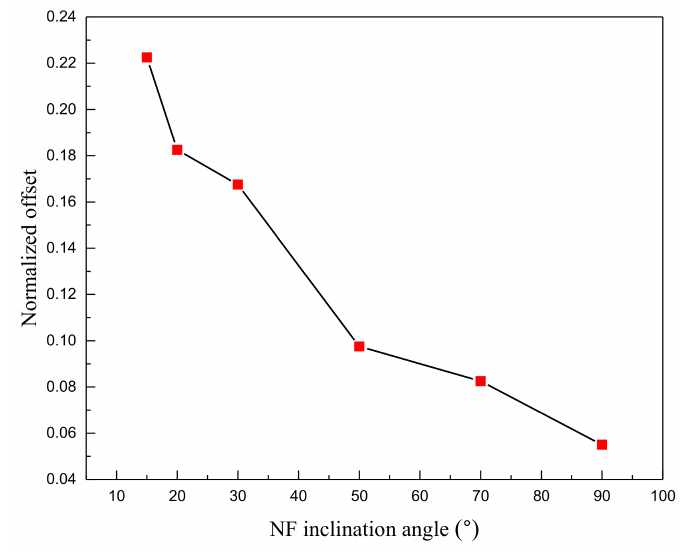
Figure 12. Maximum principal stresses along the NF at different inclinations.